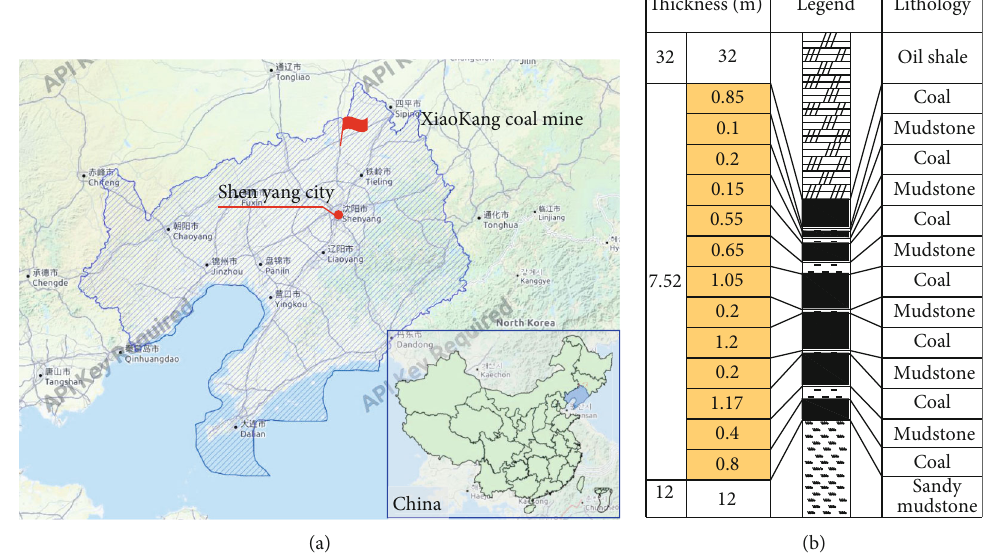
Figure 1: General situation of the Xiaokang coal mine. (a) Geographical location of the Xiaokang coal mine. (b) Coal seam of S2N5.